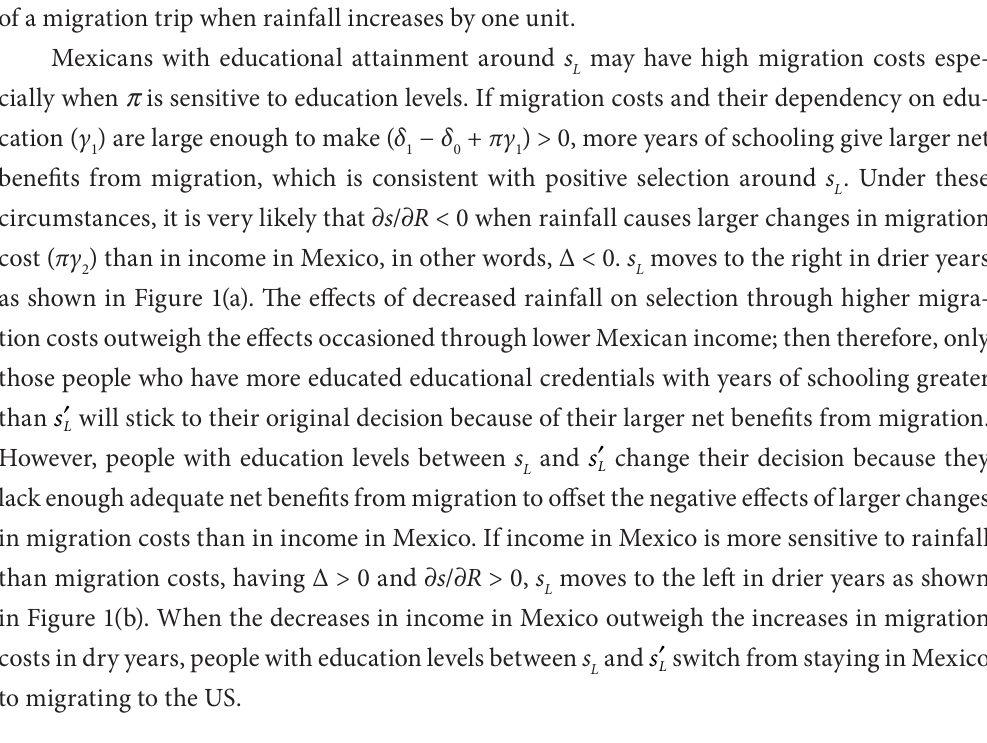
Figure 1 does not follow the convention in the literature as the straight line in the figure denotes the earnings in